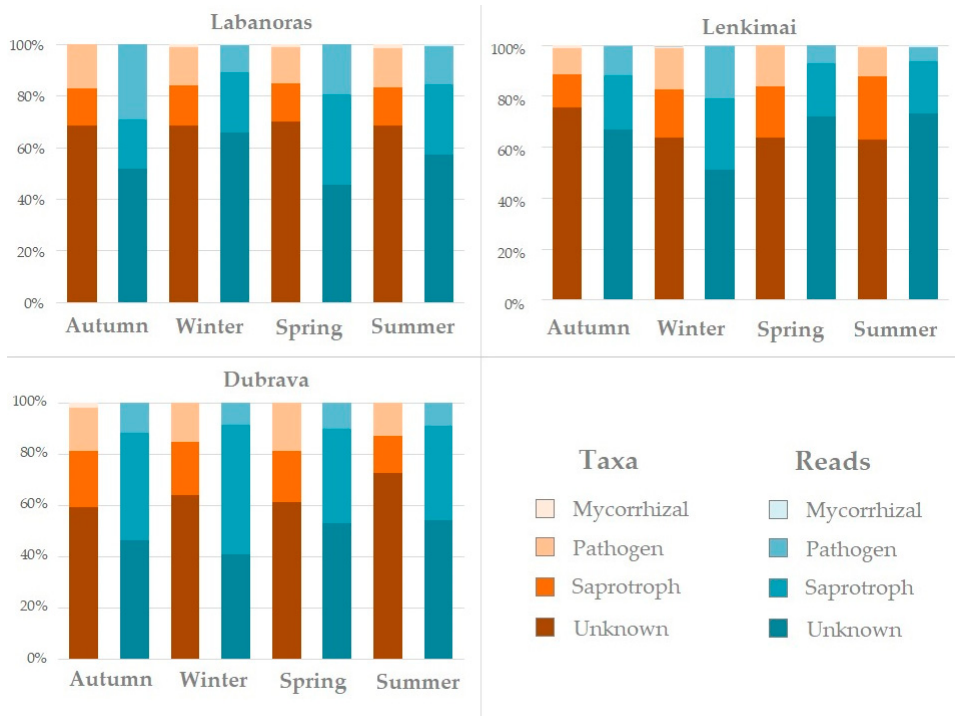
Figure 6. Relative abundance (%) of fungal functional groups (shown as fungal taxa and as sequence reads) detected in fungal spore traps from the three sampling sites in Lithuania.